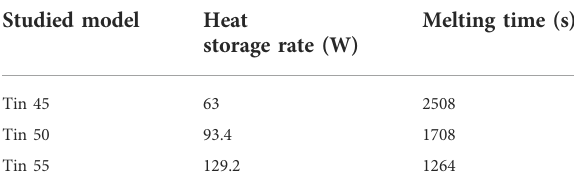
TABLE 4 Energy storage rate and melting period for case 10 for different values of Re during the charging process. Studied model